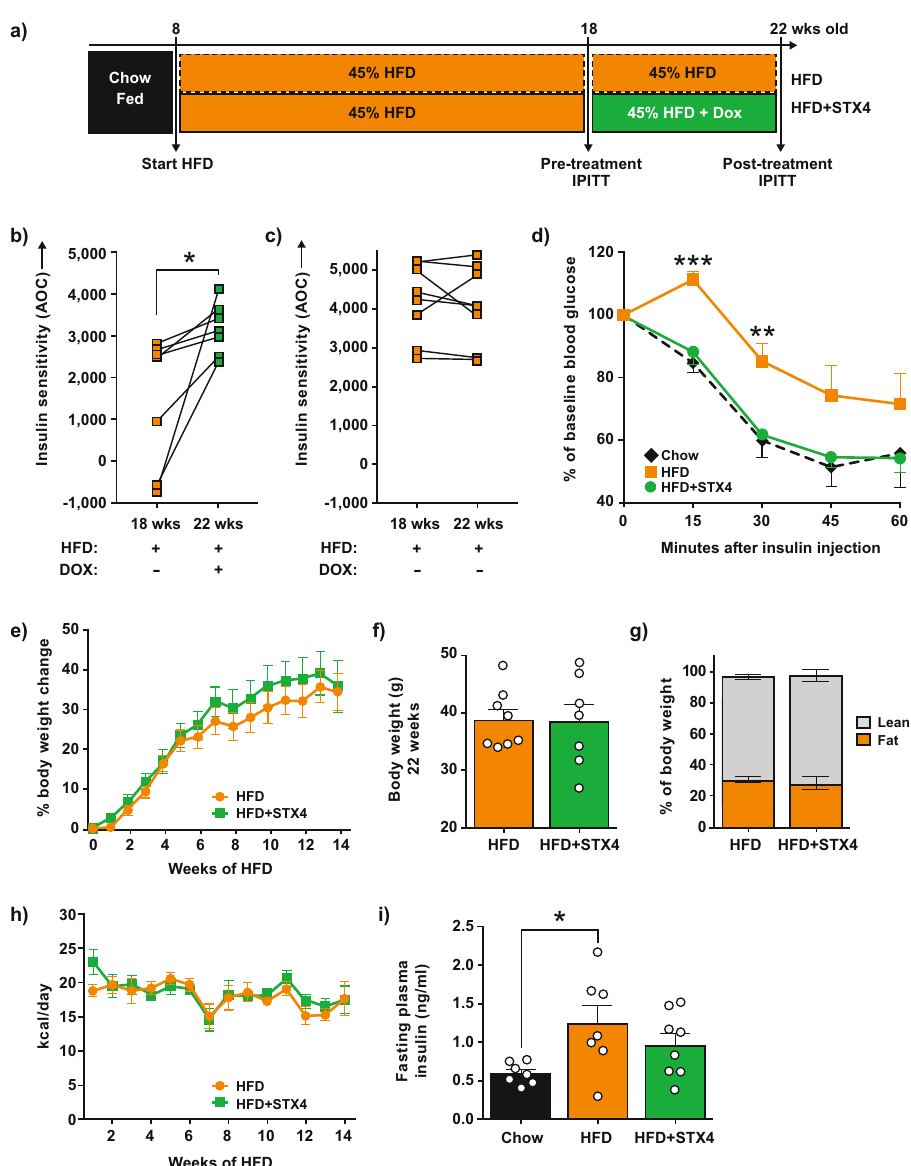
Fig. 2 Skeletal muscle-speci fi c STX4 enrichment of high-fat diet (HFD)-fed male mice reverses insulin resistance. a Schematic fl ow: Eight-week-old male Mck-rtTA:TRE-STX4 mice were placed on a 45% HFD for 10 weeks and the IPITT was used to con fi rm insulin resistance (18 weeks old, pretreatment IPITT). The skeletal muscle-speci fi c STX4 transgene was induced using 625 mg/kg Dox in the HFD in half of the mice (HFD + STX4 group), while the other half remained on only HFD (HFD group). After 4 weeks, the IPITT was performed again (22 weeks old, post-treatment IPITT). b IPITT AOC values for HFD + STX4 mice ( n = 7) pre- and post-treatment. * p = 0.0334 by paired two-tailed t-test. c IPITT AOC values for HFD mice ( n = 8). No signi fi cant differences were detected by paired two-tailed t-test. d IPITT curves from HFD-fed mice at 18 weeks old (orange; pretreatments IPITT) and the same mice after Dox treatment at 22 weeks old (green; post-treatment IPITT); chow-fed controls (black dashed) provided a reference point. Chow n = 5; HFD, HFD + STX4 n = 7 each. P values ***15 min = 0.0004; **30 min = p = 0.0013 by unpaired two-tailed t-test comparing HFD and HFD + STX4. e Cumulative percent increase in body weight in HFD and HFD + STX4 animals [HFD, n = 9; HFD + STX4, n = 8]. f Body weight at 22 weeks old [HFD, n = 8; HFD + STX4, n = 7]. g Body composition at 22 weeks old after Dox treatment [HFD, n = 8; HFD + STX4, n = 7]. h Average daily calorie consumption per week over the HFD feeding period [HFD, n = 9; HFD + STX4, n = 8]. i Plasma insulin levels in mice at 24 weeks of age, after a 6-h fast [Chow, n = 7; HFD, n = 7; HFD + STX4, n = 8]. Statistics calculated using one-way ANOVA with Tukey ’ s post hoc test, * p = 0.0298. Error bars in (d-i) represent mean ± SEM. Source data are provided as a Source Data fi le. not correlated with the effects of HFD on body fat or insulin sensitivity (Suppl. Fig. 4a, b, p value = 0.36 and 0.30 respectively). Nevertheless, these data suggest that skmSTX4tg induction is suf fi cient to partially rescue the effects of HFD feeding on structure, and reduces oxidative phosphorylation 38,39 . Thus, we assessed whether skmSTX4tg induction alters mitochondrial metabolism and fully remediate the effects on spontaneous structure and function. Using the Seahorse XFe24 fl ux analyser to activity.